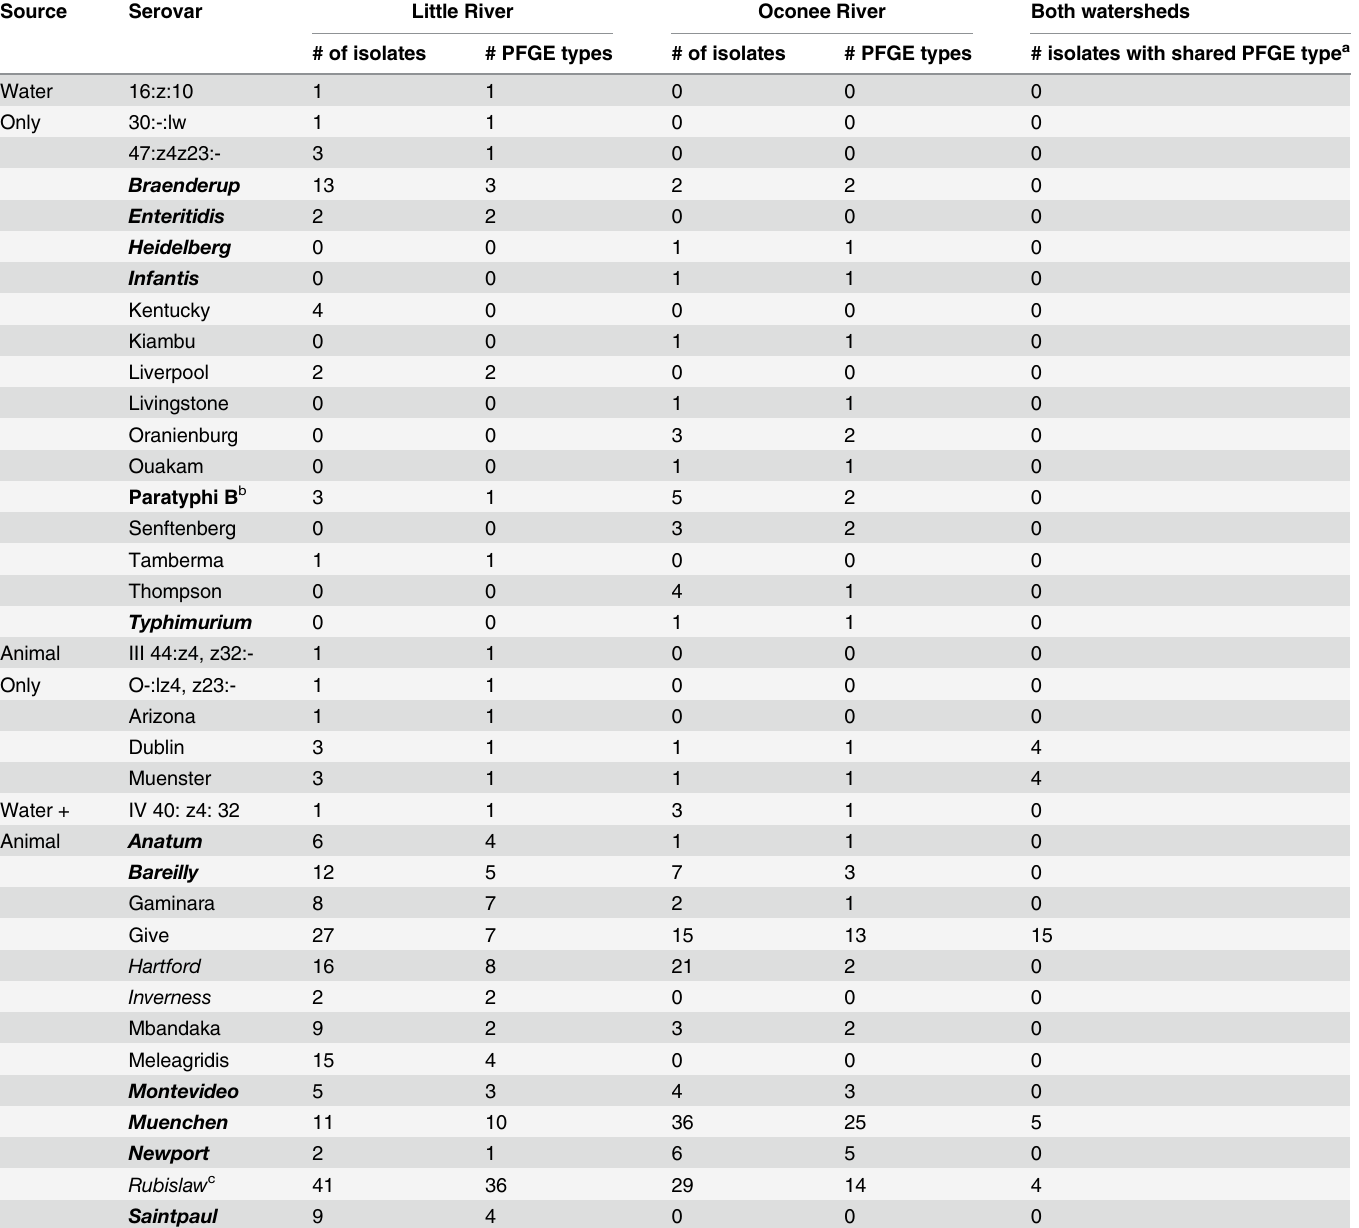
Table 1. Salmonella serovars isolated from the Little River and Oconee River watersheds (2005 – 2011). Source